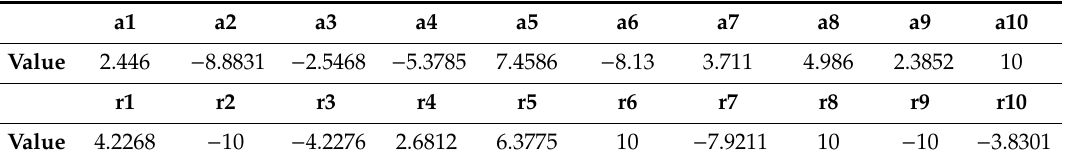
Table 2. Parameters of Prandtl-Ishlinskii